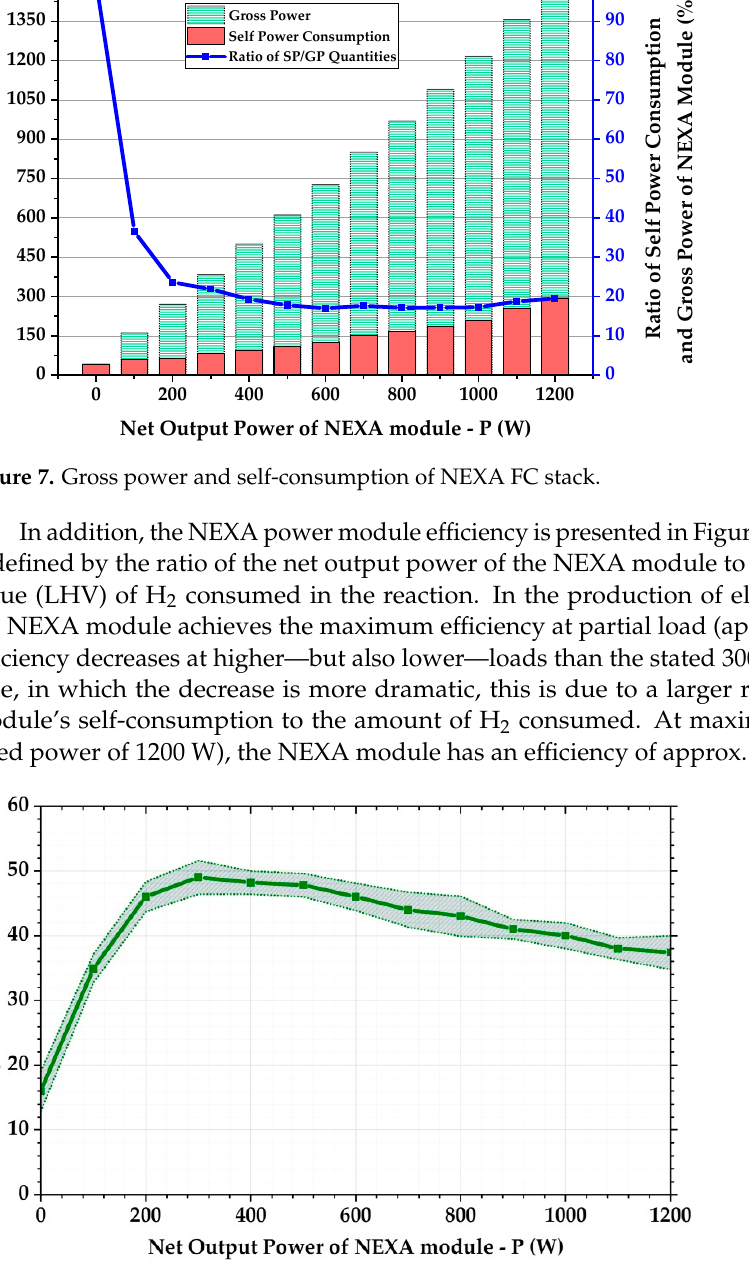
Figure 8. The output efficiency of the NEXA FC stack. NEXA low-temperature (LT) PEMFC thermography measurements were taken at different loads set on the linked electronic DC load of 100 W, 300 W, 500 W, and 1000 W. FC temperature was measured at the cathode air exhaust of the stack. There is no local overheating at low or middle PEMFC loads (in the range of 100–500 W), show significant temperature differences between parts of the stack at higher loads; see Figure 9. The left side of the stack, located closer to the entry of the cooling air supply channel, heats up significantly more. At maximum PEMFC loads (in range of 1000–1200 W), the operation temperature of the FC reaches its limit, and FC work stops due to the thermal protection of the system. On the front side of the cooling fins, shown in Figure 9b,